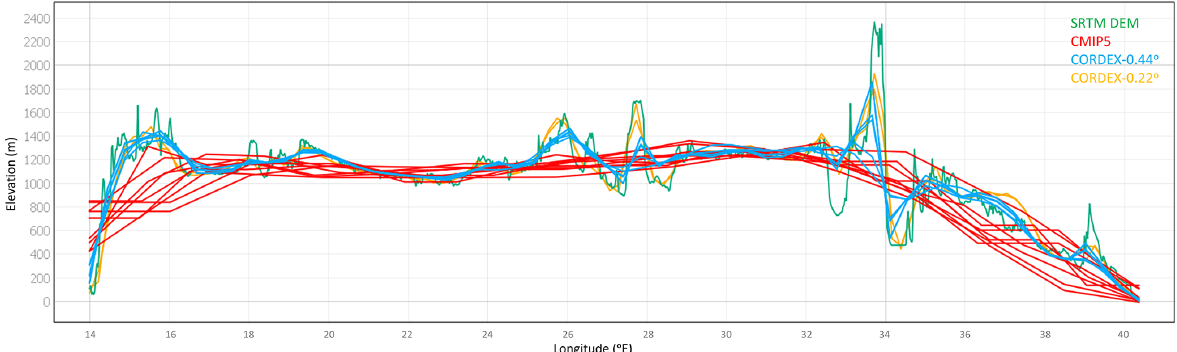
Figure 4. Cross section of surface elevation at 11 ◦ S across southern Africa for the Shuttle Radar Topography Mission (SRTM) digital elevation model (in green), the surface altitude as represented in the CMIP5 (Coupled Model Intercomparison Project Phase 5) global climate models (in red), the surface altitude as represented in the CORDEX0.44 (Coordinated Regional Climate Downscaling Experiment – Africa domain with a spatial resolution equal to 0.44 ◦ × 0.44 ◦ ) (in blue) and the surface altitude as represented in the CORDEX-0.22 ◦ (CORDEX-Africa simulations with a spatial resolution equal to 0.22 ◦ × 0.22 ◦ ) (in